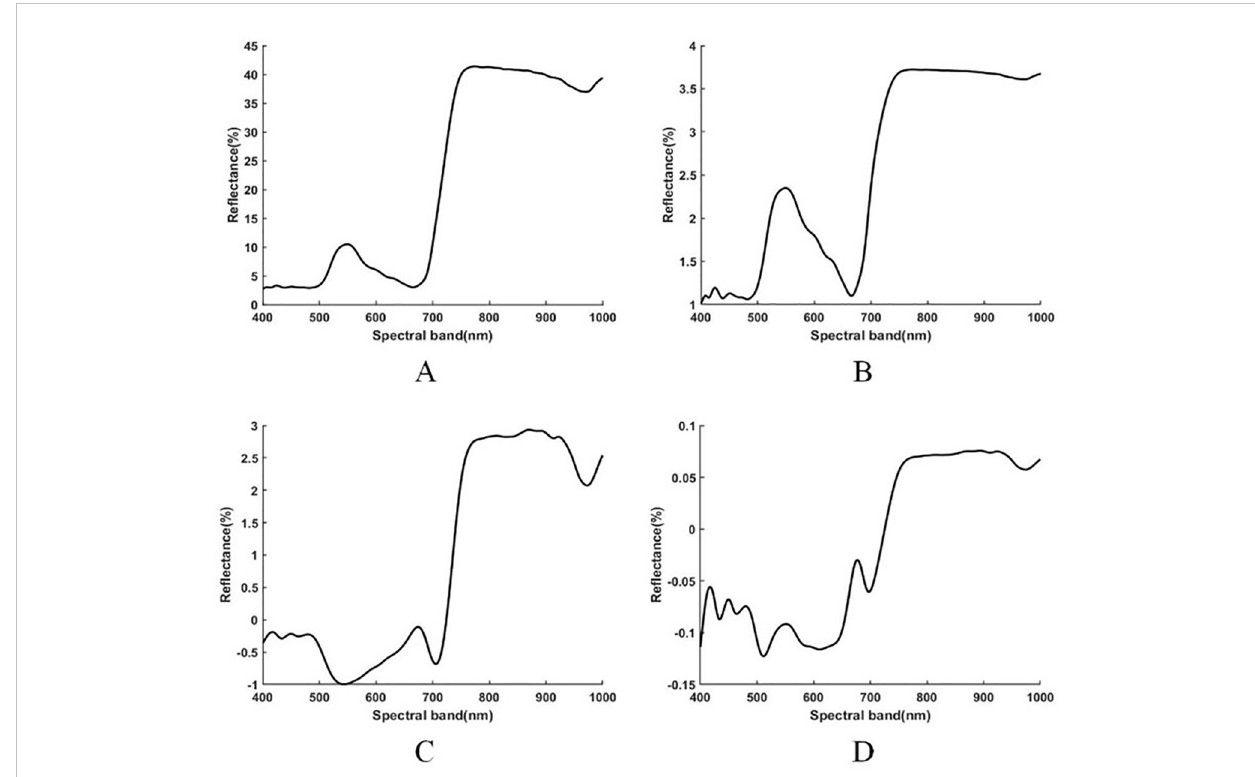
FIGURE 4 Spectral re fl ectance of raw, logarithmic, difference, and log-difference spectra [ (A – D)